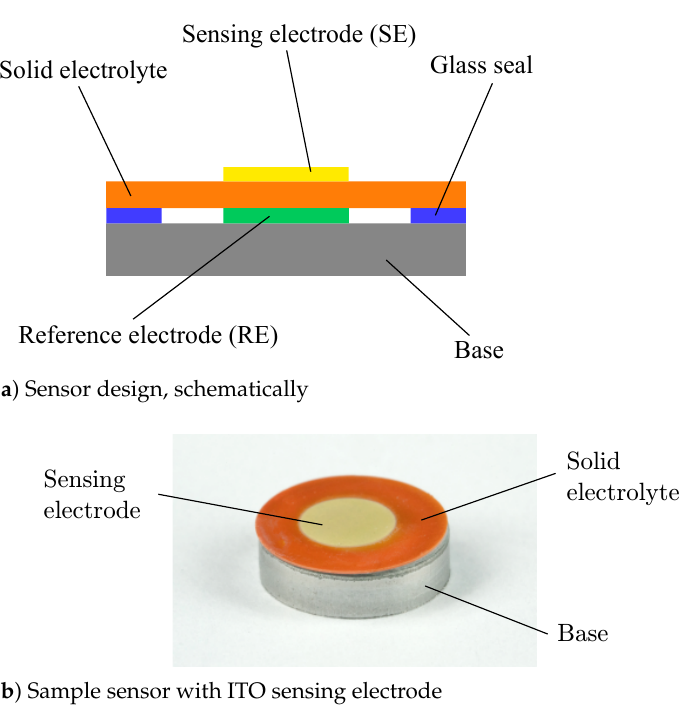
Figure 1. Potentiometric zirconia solid electrolyte sensor with internal